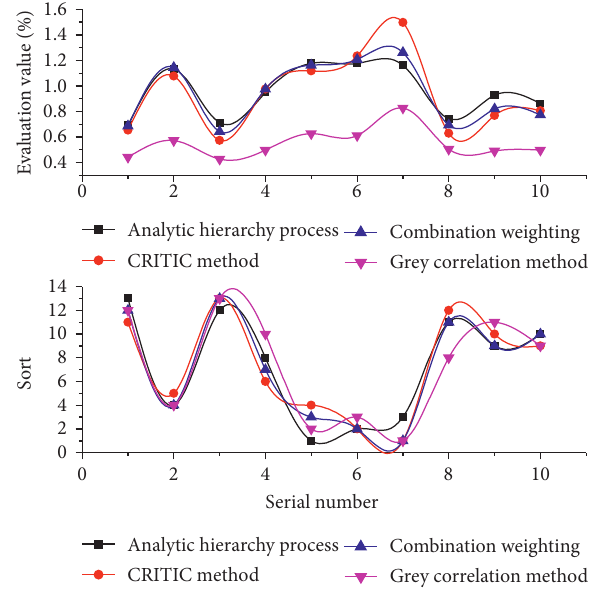
Figure 8: Standardized evaluation values of each evaluation